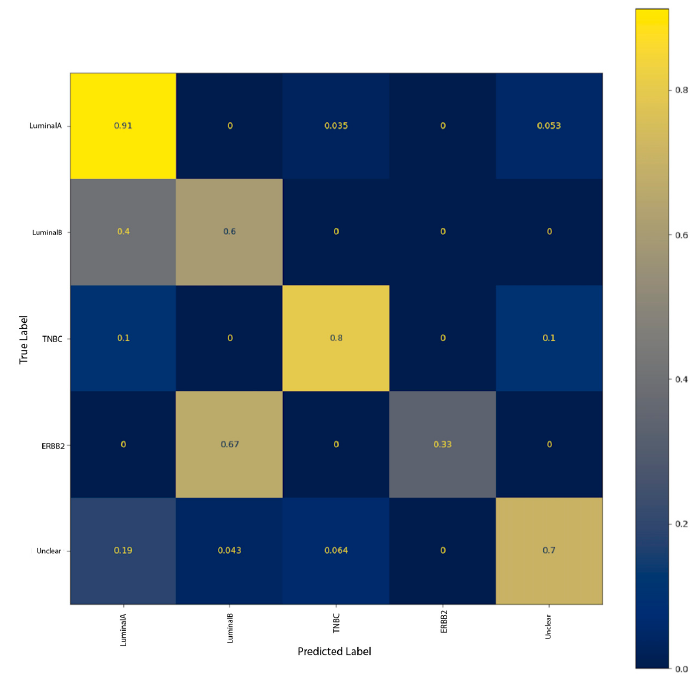
Figure 10. Normalized confusion matrix for S2HT1 classification.